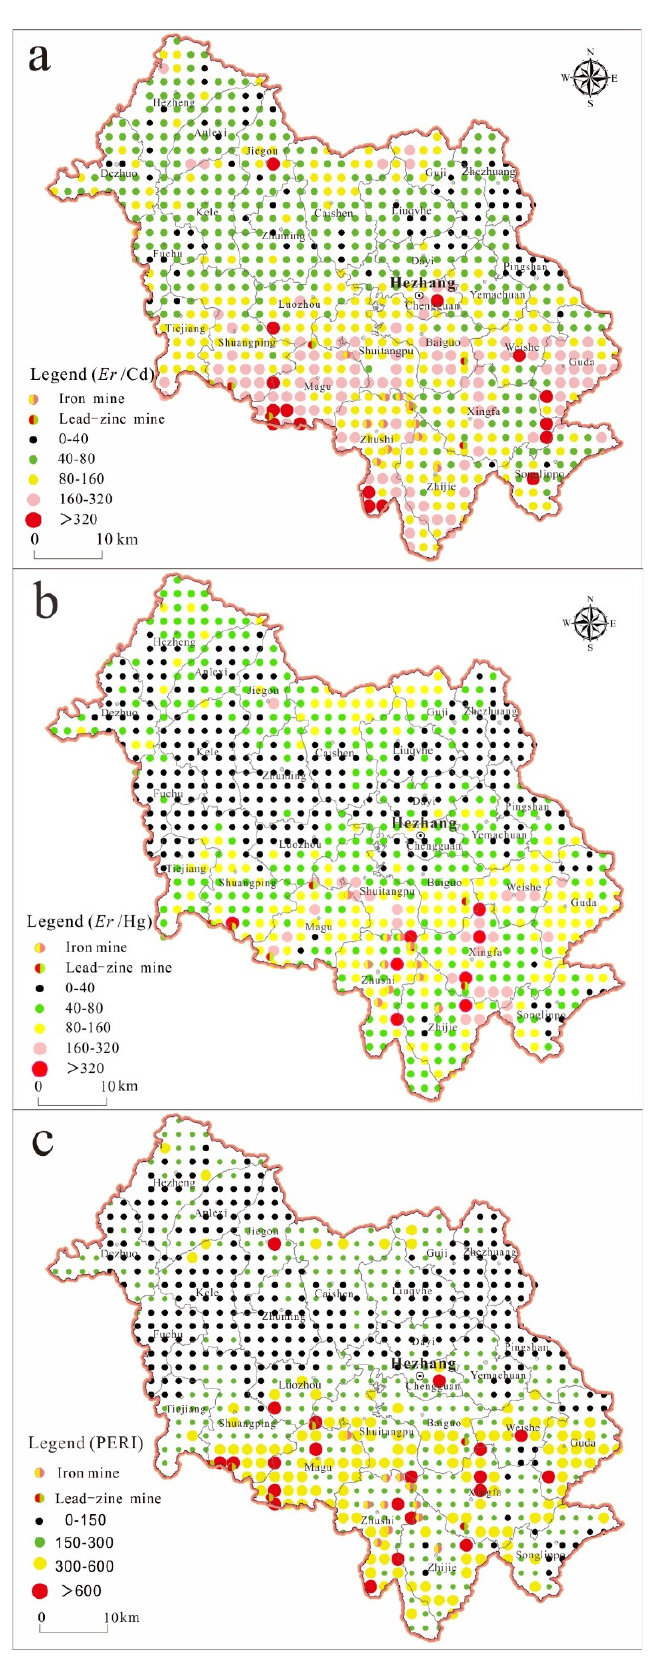
Figure 6. Spatial distribution of potential ecological risks of Cd ( a ), Hg ( b ) and eight heavy metals ( c ) in study